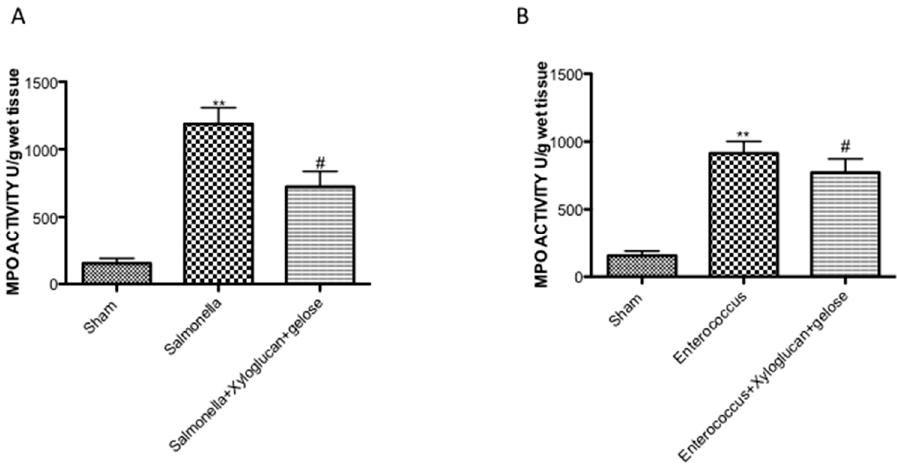
Figure 2. ( A ) The sham group; ( B ) Intestine from E. hirae inoculated rats showed transmural necrosis, edema, and leukocyte infiltration in the submucosa of tissue compared to the sham group; ( C ) Xyloglucan + gelose treatments appreciably reduced the degree of tissue injury; and ( D ) The histological score. Values are means ± SEM of 10 animals for each group. *** p < 0.001 vs. Sham, # p < 0.05 vs. E. hirae .